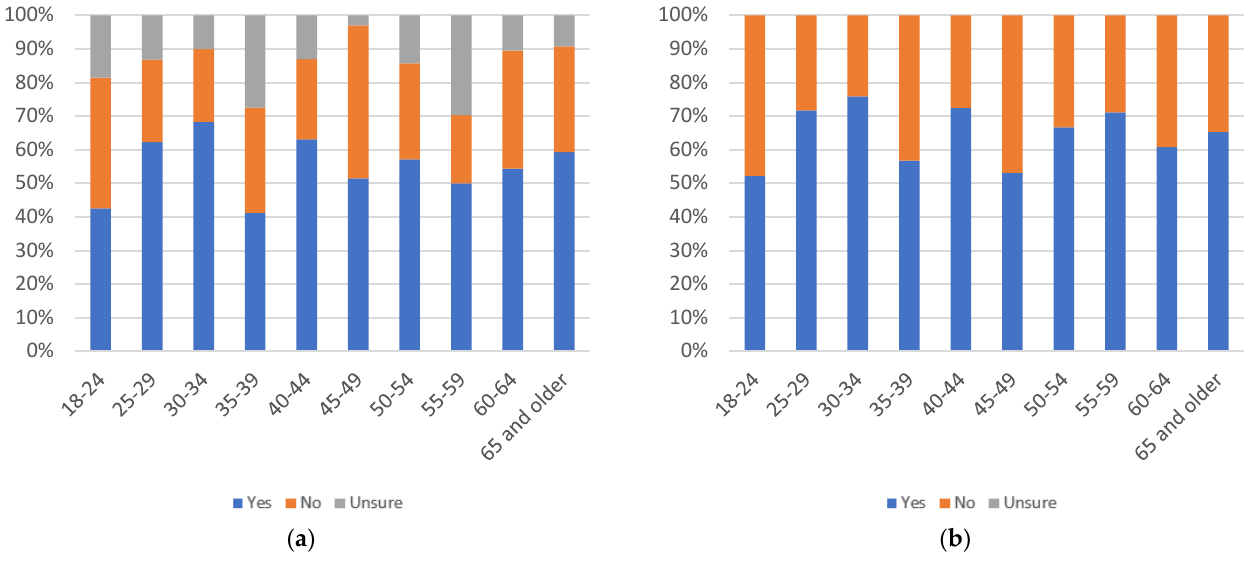
Figure 43. Label use, by age group: ( a ) with uncertain respondents (left) and ( b ) without uncertain respondents (right).